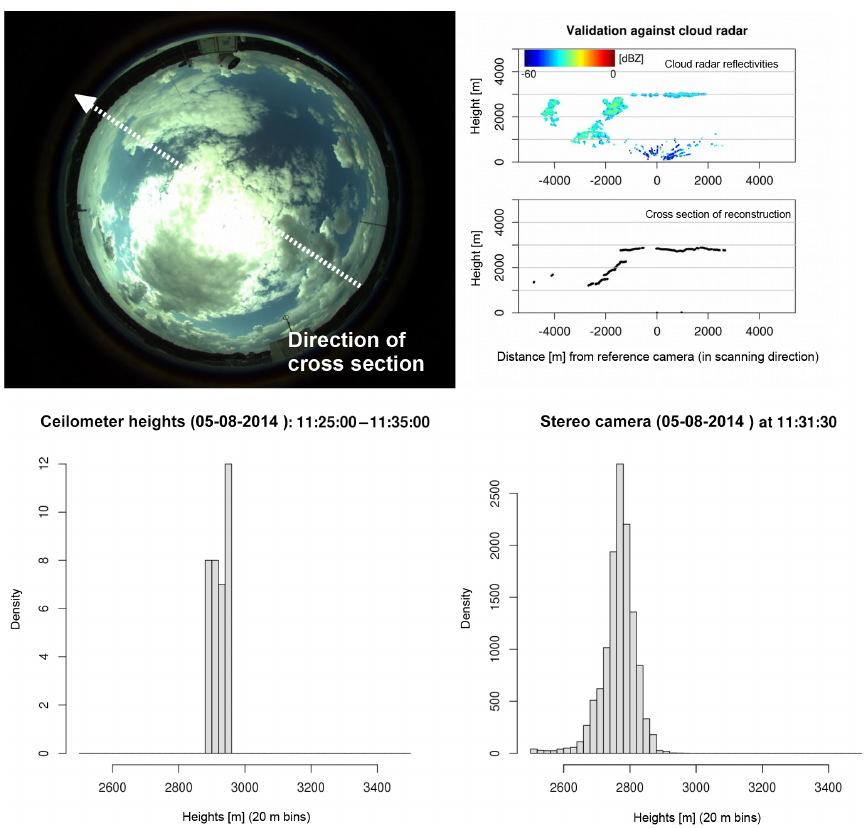
Figure 15. Comparison of the reconstruction with cloud radar and lidar at 5 August 2014, 11:31:30UTC; as in Fig.